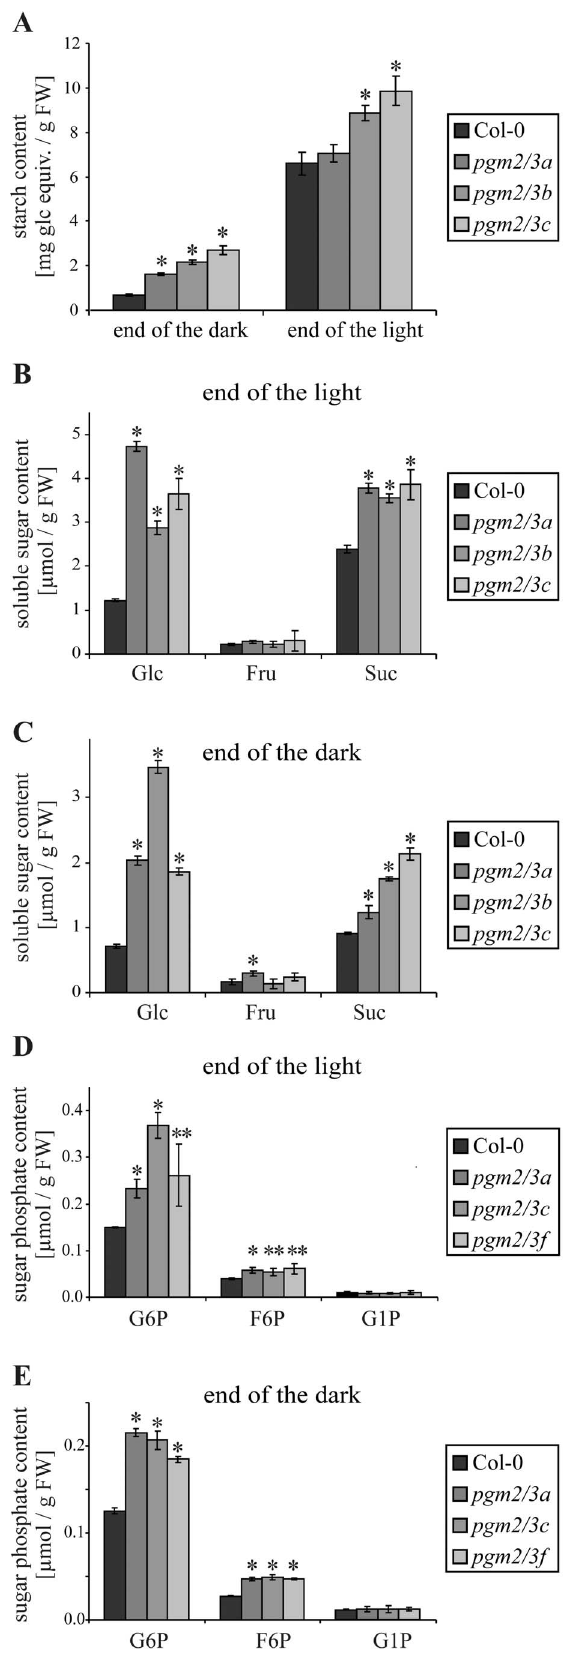
Figure 2. Carbohydrate analysis of Col-0 and pgm2/3 plants. A – E, Plants were grown under 12 h light/12 h dark conditions and after five weeks 7–8 plants were collected and homogenized per line. Values are means of four technical replicates (A–C), and three technical parallels (D–E) 6 SD, respectively. A, Starch content. B–C, Soluble sugar content. D–E, Sugar phosphate content. Asterisks denote the signif- icance levels comparing pgm2/3 mutants to Co1-0: * p # 0.01; ** p #